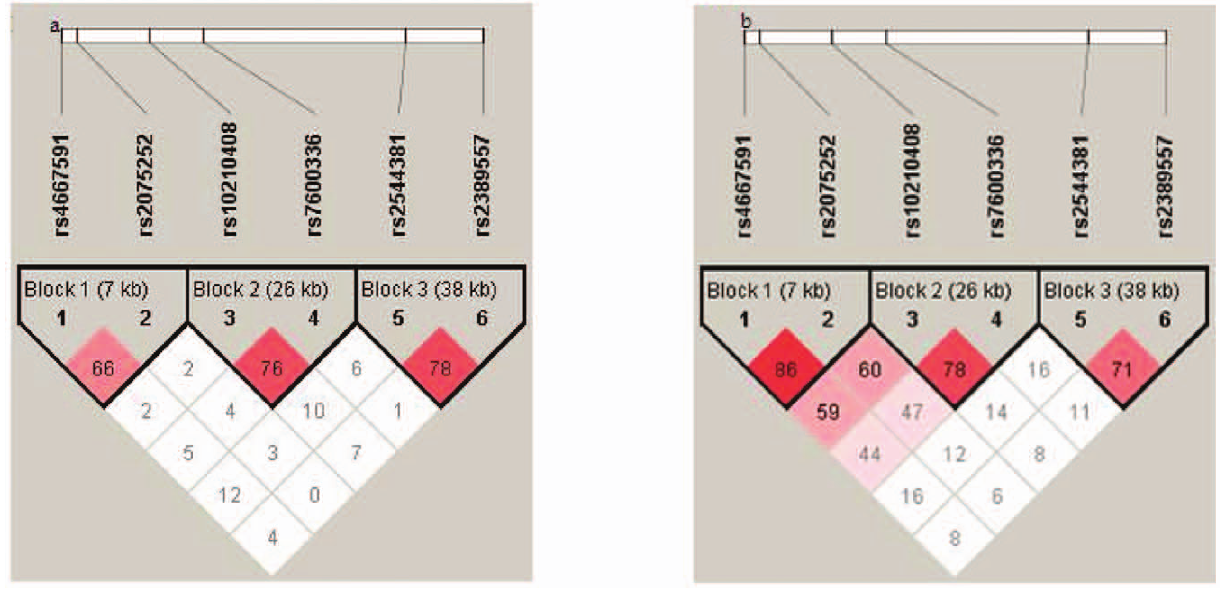
Figure 1. Haplotype linkage disequilibrium (LD) blocks in 330 female-offspring nuclear families and 400 male-offspring nuclear families. Three LD blocks connecting SNP pairs are shaded based on the LD strength between SNPs by using the disequilibrium coefficient r 2 , darker shades of red indicate higher value of D’, up to maximum of 1. Figure 1a shows the LD pattern in the LRP2 gene based on the parents genotypes from 330 female-offspring nuclear families (n=660), while figure 1b presents the LD pattern from 400 male-offspring nuclear families ( n =800).